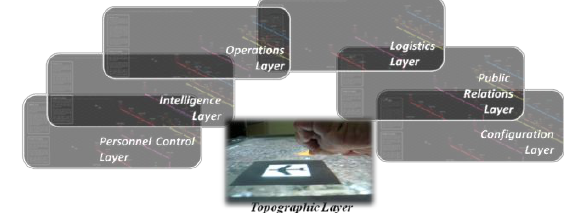
Figure 1. Multi Layered Command &Control Interface.